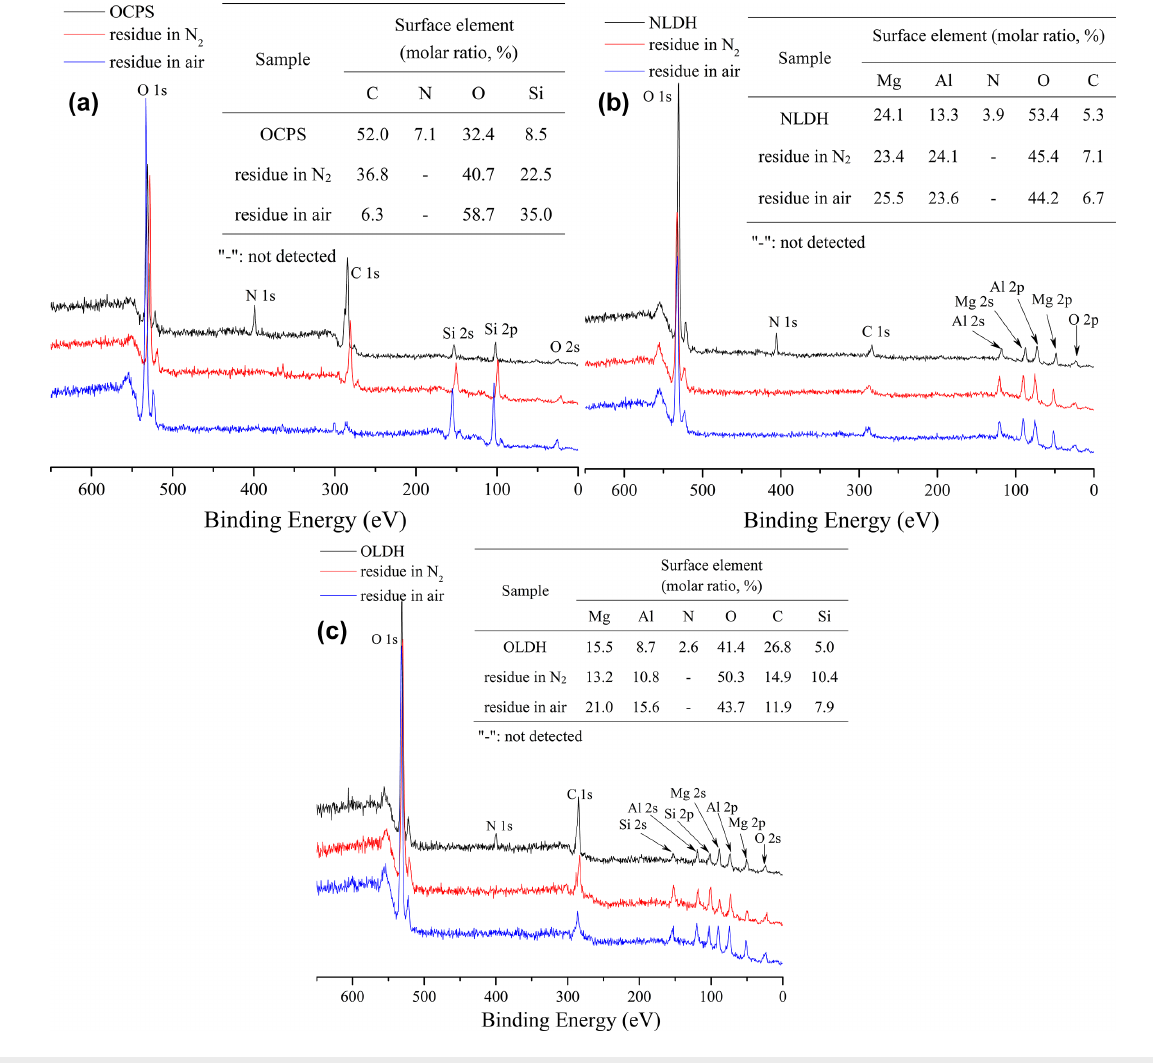
This research offers a new approach to preparing modified LDHs with enhanced thermal stability and low flammability, and the POSS-modified LDH is expected to represent a power- ful candidate for applications in LDH-based